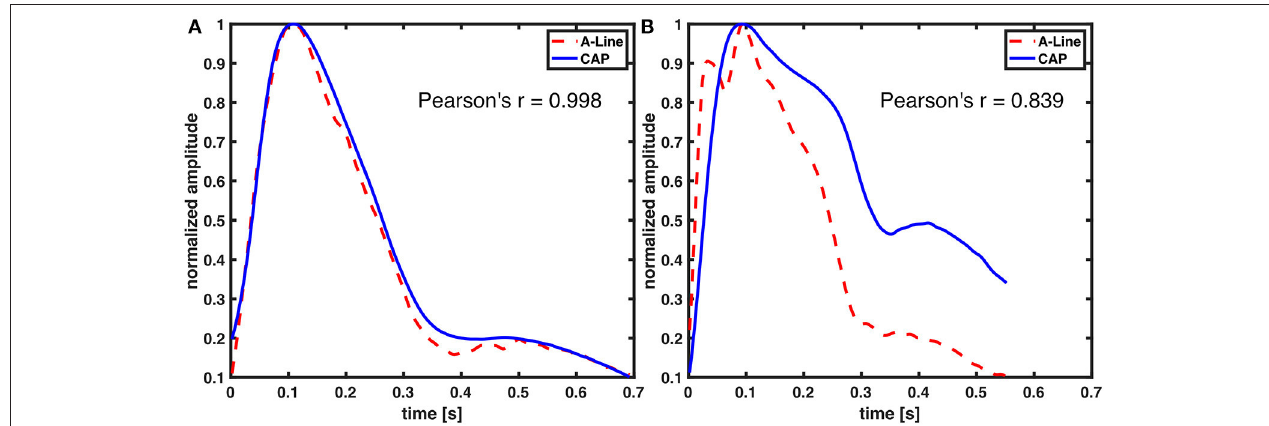
FIGURE 8 | Comparison of A-Line and CAP waveform similarity. Both of the waveforms were derived from radial arteries. Representative figures with (A) high and (B) low Pearson correlation coefficient.